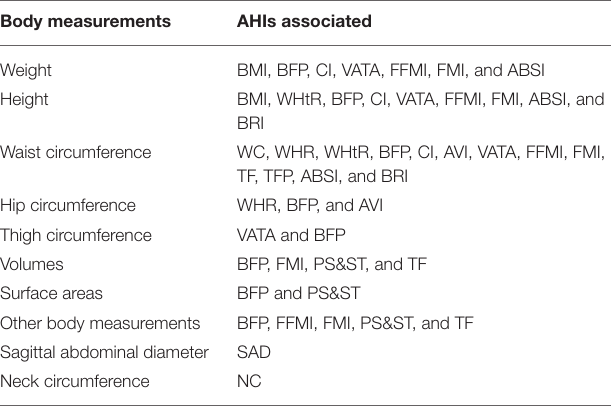
TABLE 3 | Main parameters obtained from 3D human shapes and used to estimate AHIs. Body